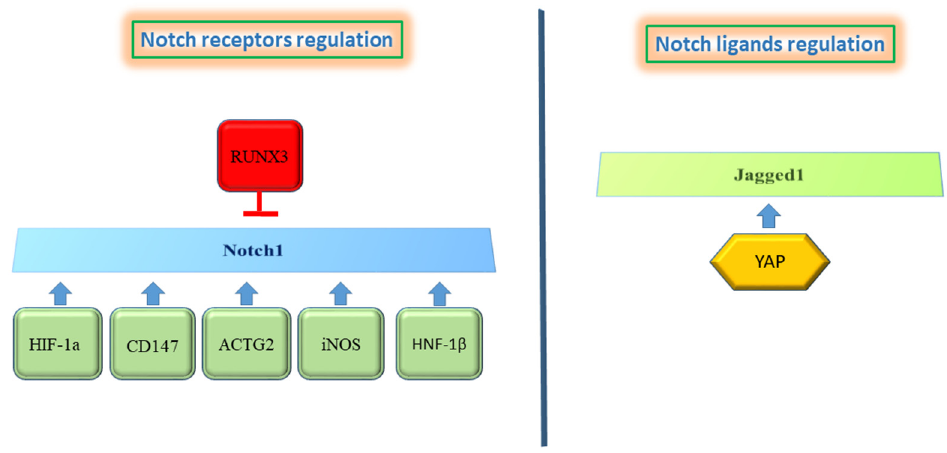
Figure 3. Proteins regulating the Notch pathway. the left panel shows proteins that induce Notch1 up-regulation, whereas Runx3 results in Notch1 inhibition. Only YAP protein is described to regulate Notch ligands (right panel).